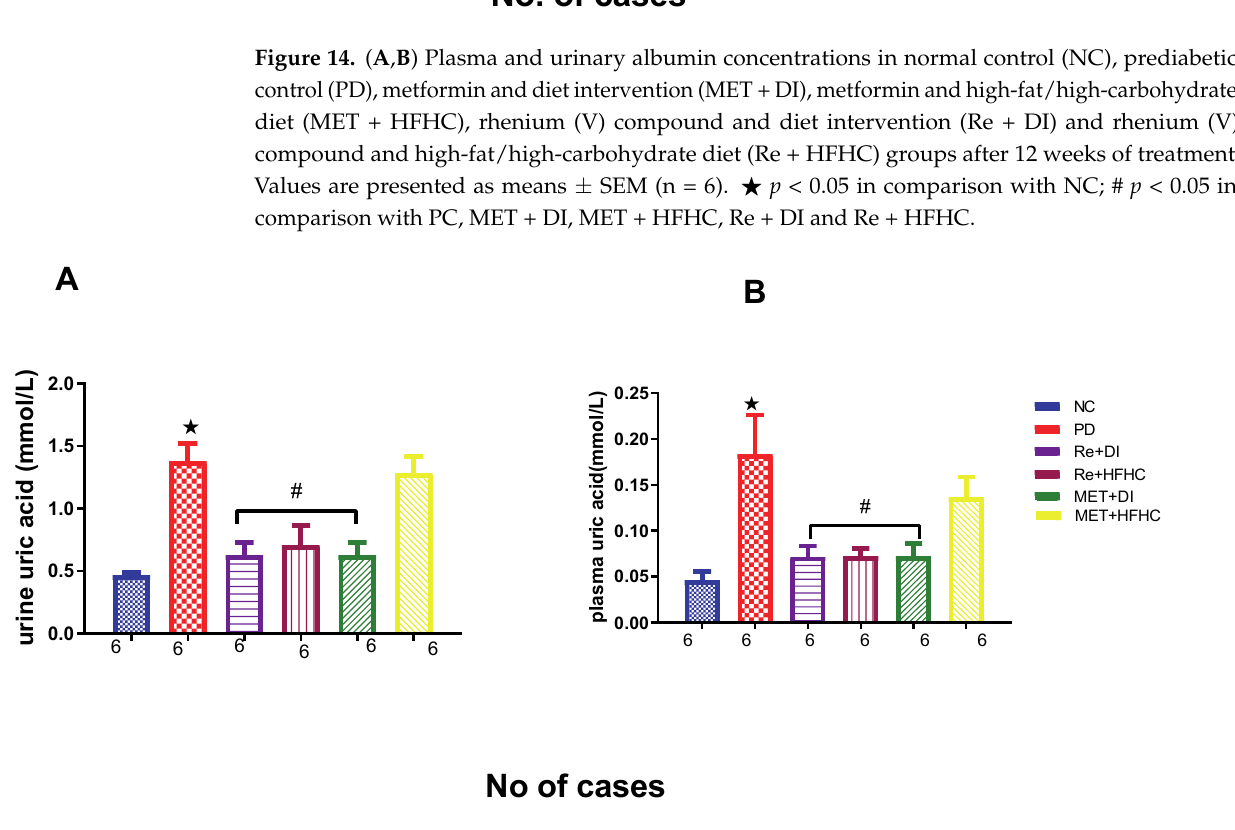
Figure 15. ( A , B ) Plasma and urinary uric acid concentrations in normal control (NC), prediabetic control (PD), metformin and diet intervention (MET + DI), metformin and high-fat/high-carbohydrate diet (MET + HFHC), rhenium (V) compound and diet intervention (Re + DI) and rhenium (V) compound and high-fat/high-carbohydrate diet (Re + HFHC) groups after 12 weeks of treatment. Values are presented as means ± SEM (n = 6). (cid:70) p < 0.05 in comparison with NC; # p < 0.05 in comparison with PC, MET + DI, MET + HFHC, Re + DI and Re + HFHC. Figure 16A,B show urinary and plasma urea concentrations in the normal control (NC), prediabetic control (PD), metformin and diet intervention (MET + DI), metformin and high-fat/high-carbohydrate diet (MET + HFHC), rhenium (V) compound and